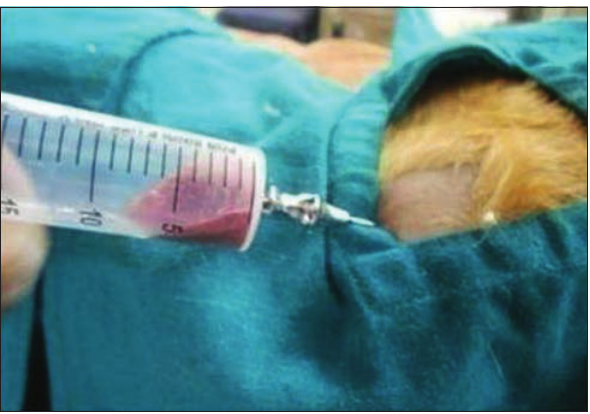
Figure-1: Aspiration of bone marrow from the iliac crest of